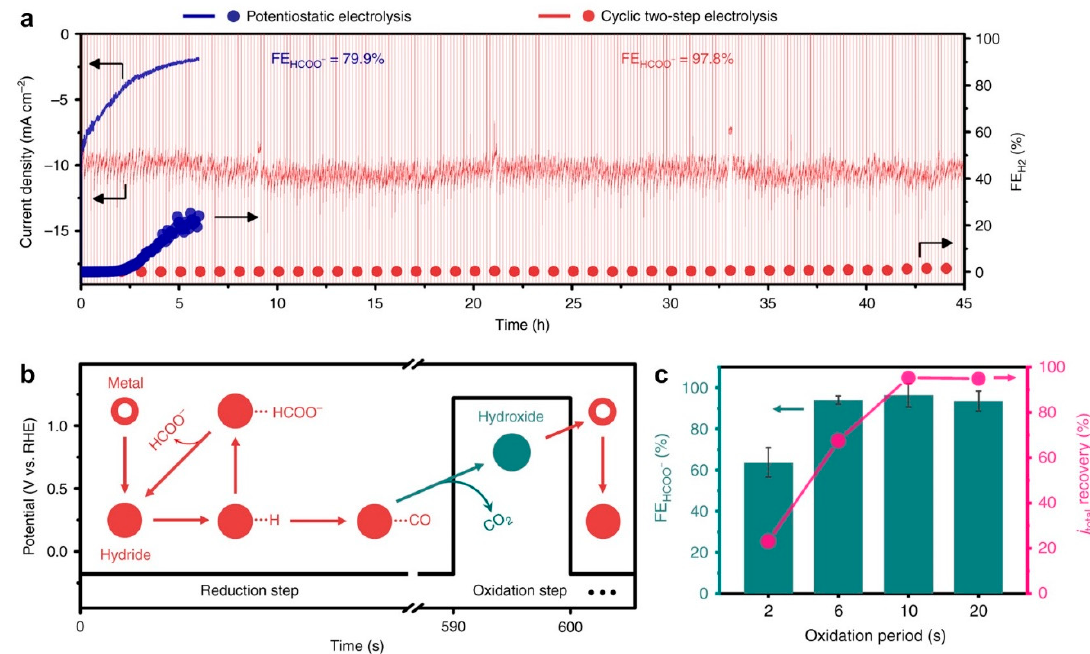
Figure 16. ( a ) Comparison of the cyclic two ‐ step electrolysis and potentiostatic electrolysis in terms of current density and product selectivity; ( b ) potential program and reaction scheme for the cyclic two ‐ step electrolysis; ( c ) the dependence of the current density recovery ( j total ) and the HCOO − FE on the oxidation period (reproduced with permission from ref. [58], copyright 2019, Springer Nature).